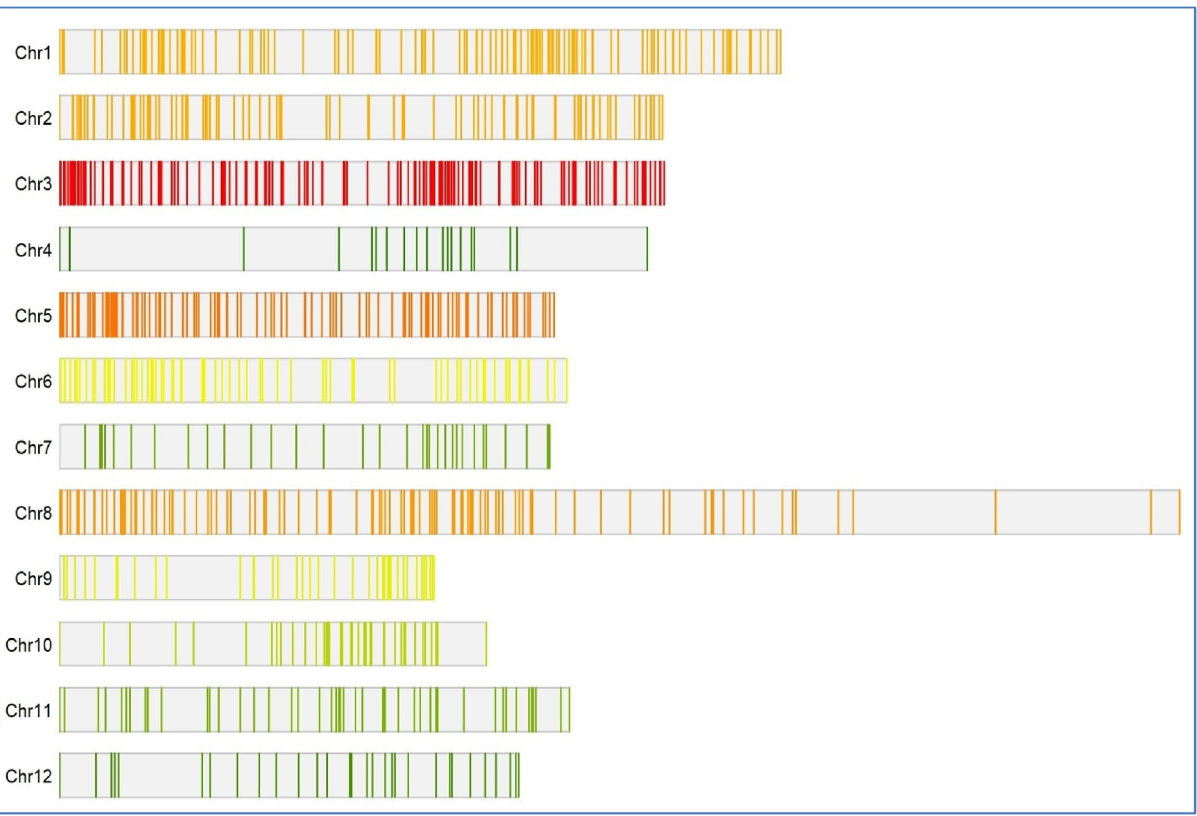
Figure 1. Distribution of the markers on the rice consensus map constructed and utilized for meta-QTL analysis in the present study (Color intensity from white to red indicate low to high density of marker, respectively).